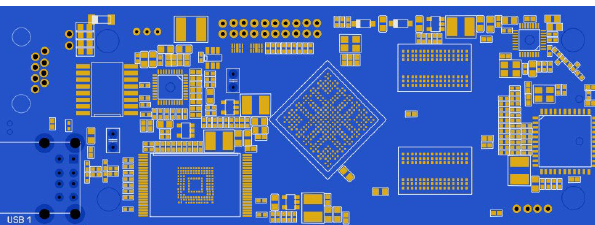
Figure 5. The architecture of the mainboard for gateway nodes